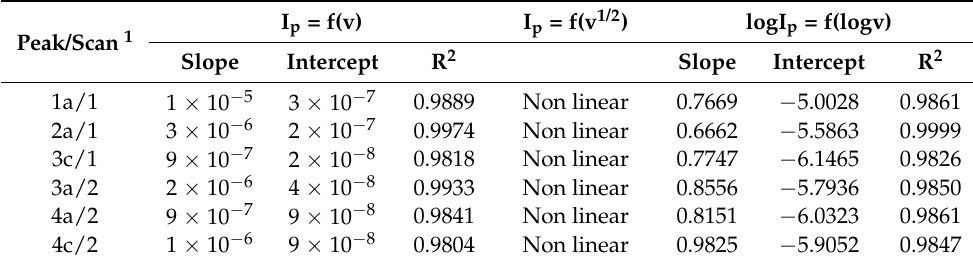
Table 2. The parameters of the regression equations corresponding to the different dependencies of the peak currents on the scan rate for DIO oxidation signals obtained by the CVs from Figure 8. Peak/Scan 1